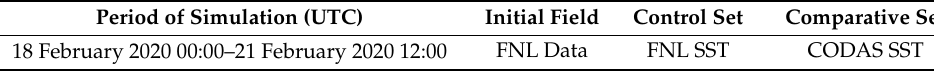
Table 1. The start time of simulation is at 00:00 UTC on 18 February 2020, the end time is at 12:00 UTC on 21 February 2020, the forecast horizon is 84 h. Table 1. Scheme for numerical simulations.